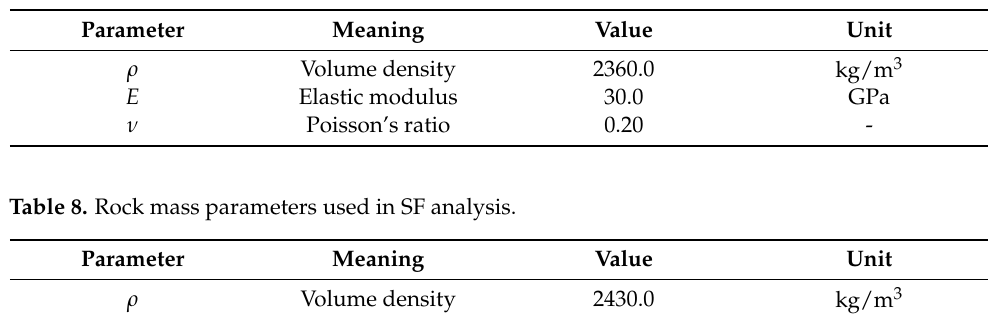
Table 7. Concrete parameters used in SF analysis.